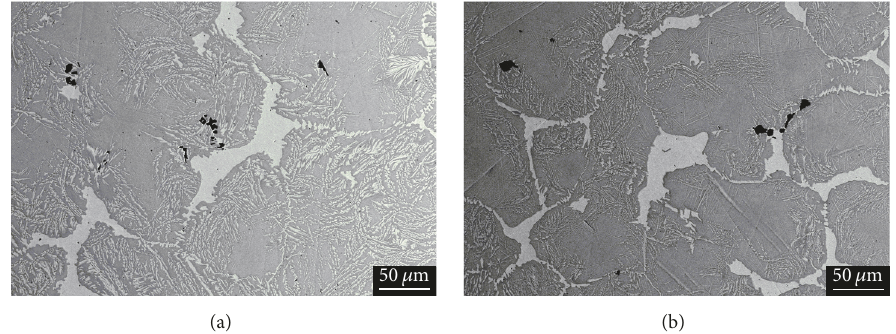
Figure 4: A typical microstructure of the Cr-Ni-base alloys I (a) and II (b) (SEM, the etched surface of the sample). Note of the large areas (light) of 𝛾 -phase near GBs in 𝛼 -matrix